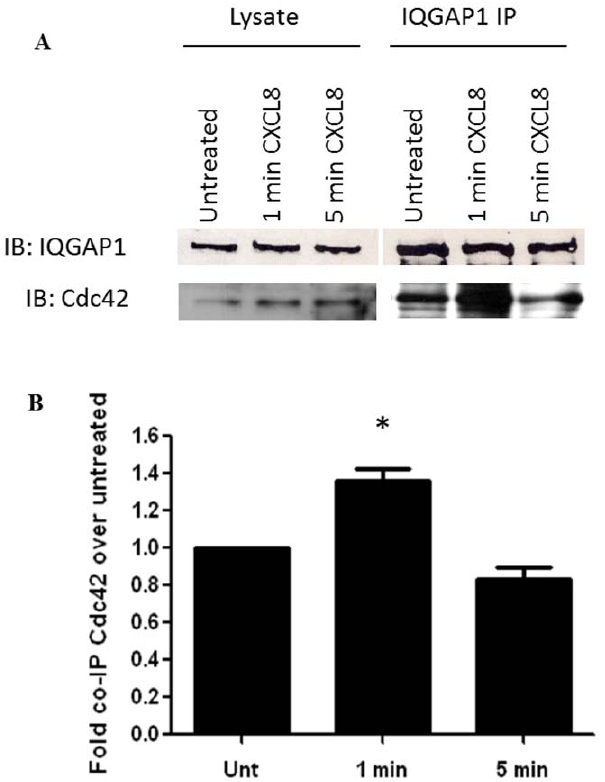
Figure 5. Interaction of IQGAP1 with Cdc42 is enhanced by CXCL8 stimulation. Lysates from cells stimulated with vehicle (Mock, Untreated) or cells stimulated with 100 ng/ml CXCL8 for 1 minute or 5 minute were incubated with either normal rabbit IgG- (Mock IgG) or rabbit anti-IQGAP1 antibody and Protein A/G agarose beads. Immuno- precipitated proteins were eluted with Laemmli sample buffer (A) Representative western blot of samples analyzed by SDS-PAGE and immunoblotted (IB) for IQGAP1 and Cdc42 (B) Quantitation using densitometry of fold increase in amount of Cdc42 that co-immunopre- cipitated with IQGAP1 following CXCL8 stimulation over amount of Cdc42 that co-immunoprecipitates from lysates of untreated cells. Graph represents mean fold increase 6 s.e.m. from three separate experiments. There is a statistically significant increase in the amount of Cdc42 that co-immunoprecipitates with IQGAP1 following 1 minute of CXCL8 stimulation as represented by the asterisk (p-value , 0.05, Mann Whitney